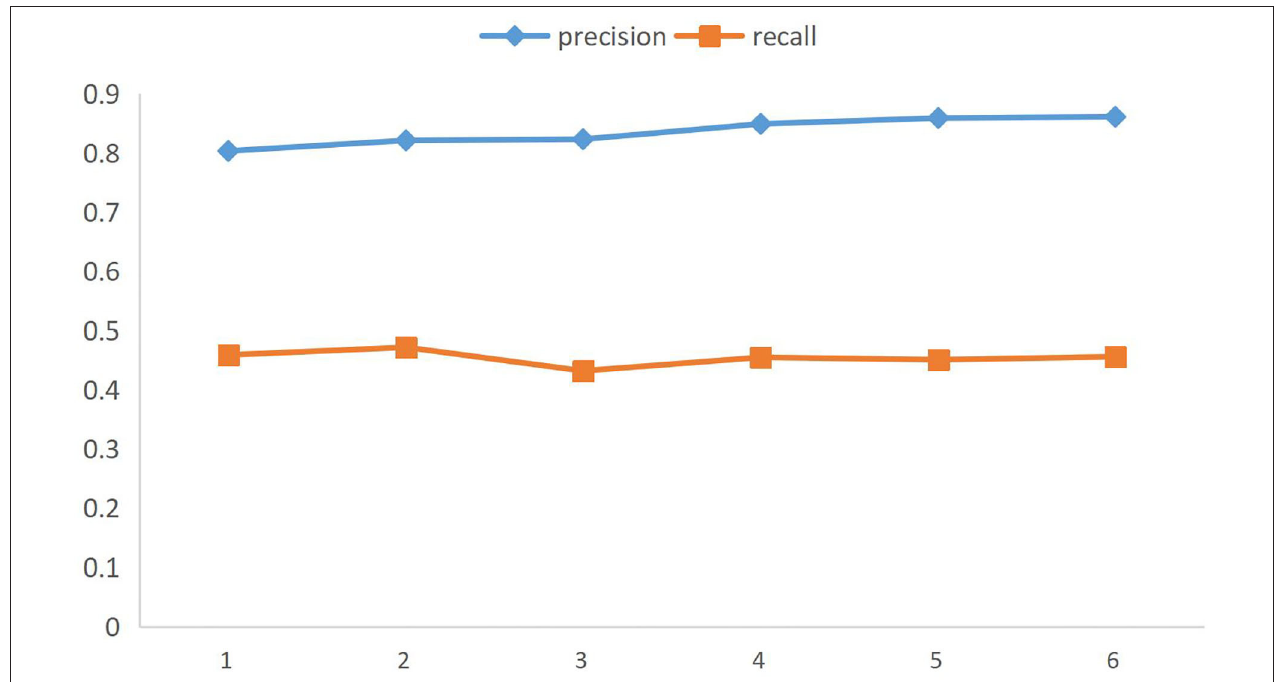
FIGURE 3 | Figure of CRF model with brand data quantity.